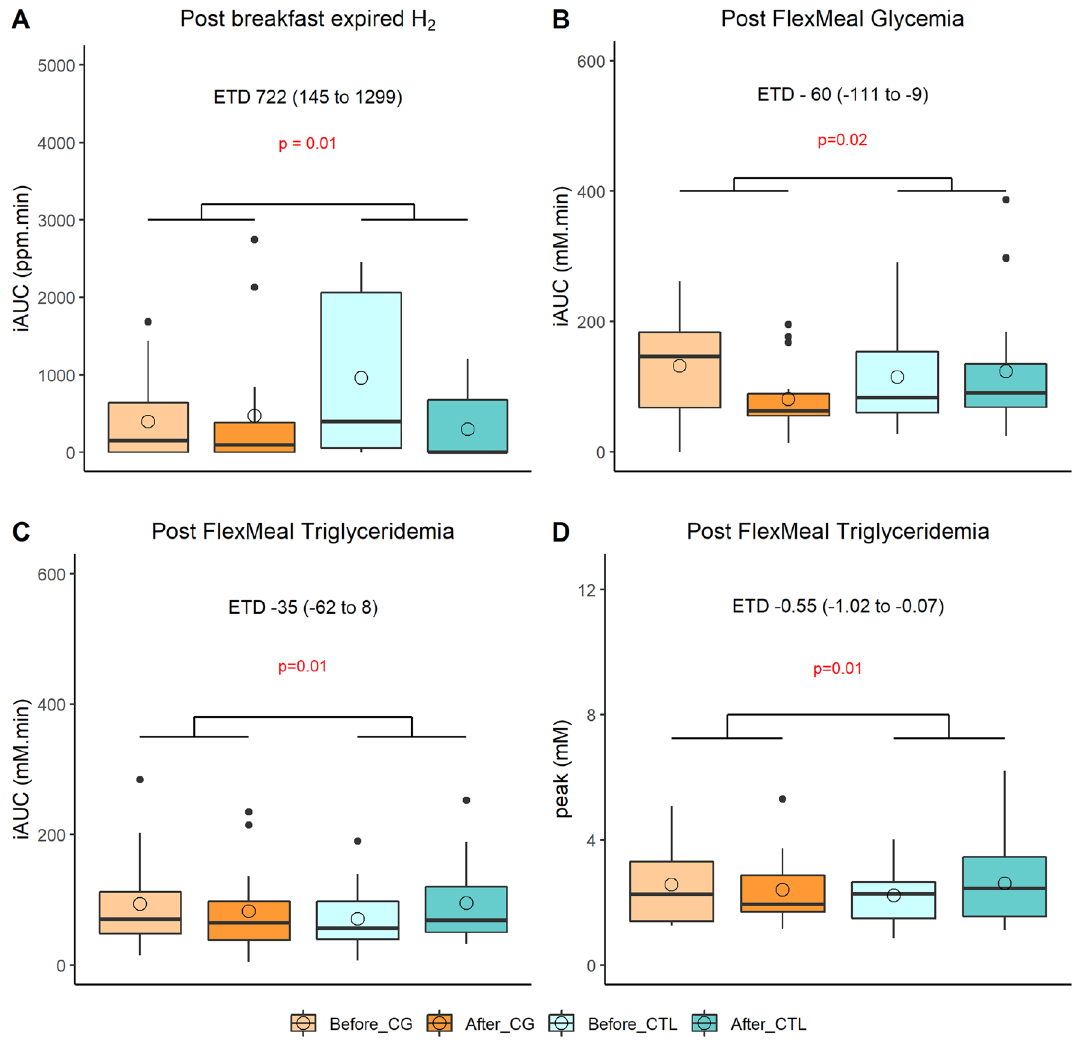
Figure 3. Impacted postprandial metabolic parameters (n = 15). ( A ) iAUC of postprandial exhaled H 2 following the ingestion of a fiber-enriched breakfast, iAUC of postprandial glycaemia ( B ), triglyceridemia ( C ) and triglyceridemia peak ( D ) following the ingestion of a standardized test meal challenge at lunch. Empty circles and horizontal lines within each box represent respectively the mean and median values. iAUC, incremental area under the curve; CG, chitin glucan; CTL, control. A mixed linear model for repeated measures with treatment, time, period and sequence as fixed variables and subjects as random effect has been performed. p values associated to CG effect assessed with the estimated treatment difference (ETD) and its 95% confidence interval are shown and considered as significant when <